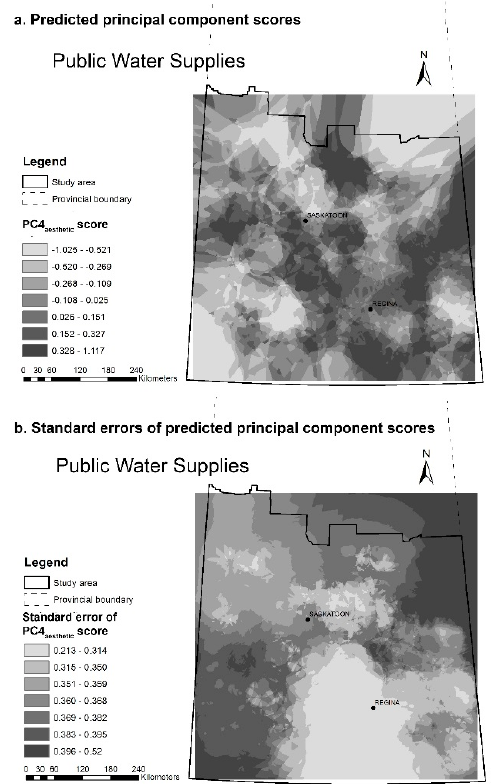
Figure A15. ( a ) Predicted PC4 aesthetic scores for public water supplies in study area; and ( b ) the corresponding prediction standard errors. The fourth principal component was extracted for public water supply data only.